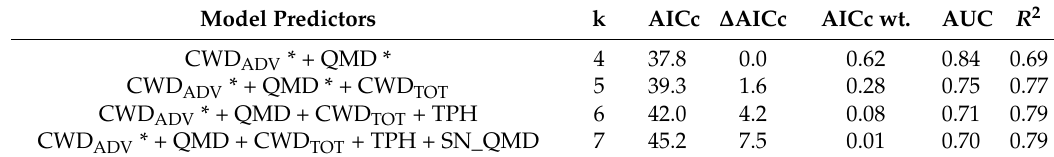
Table 2. Ranking of models (increasing AICc) using variables identified in the preliminary random forest analysis used to predict old-growth status; CWD ADV = advanced-decay coarse woody debris volume; QMD = quadratic mean diameter, live trees; CWD TOT = total coarse woody debris volume; TPH = live trees per hectare; SN_QMD = standing dead (snag) quadratic mean diameter. * denotes significance ( p ≤ 0.05); k = number of model parameters; AICc = corrected Akaike information criterion; ∆ AIC = change in Akaike information criterion; AICc wt. = corrected Akaike information criterion weights; AUC = Area under the curve, an assessment of model fit; R 2 refers to a pseudo R 2 calculated